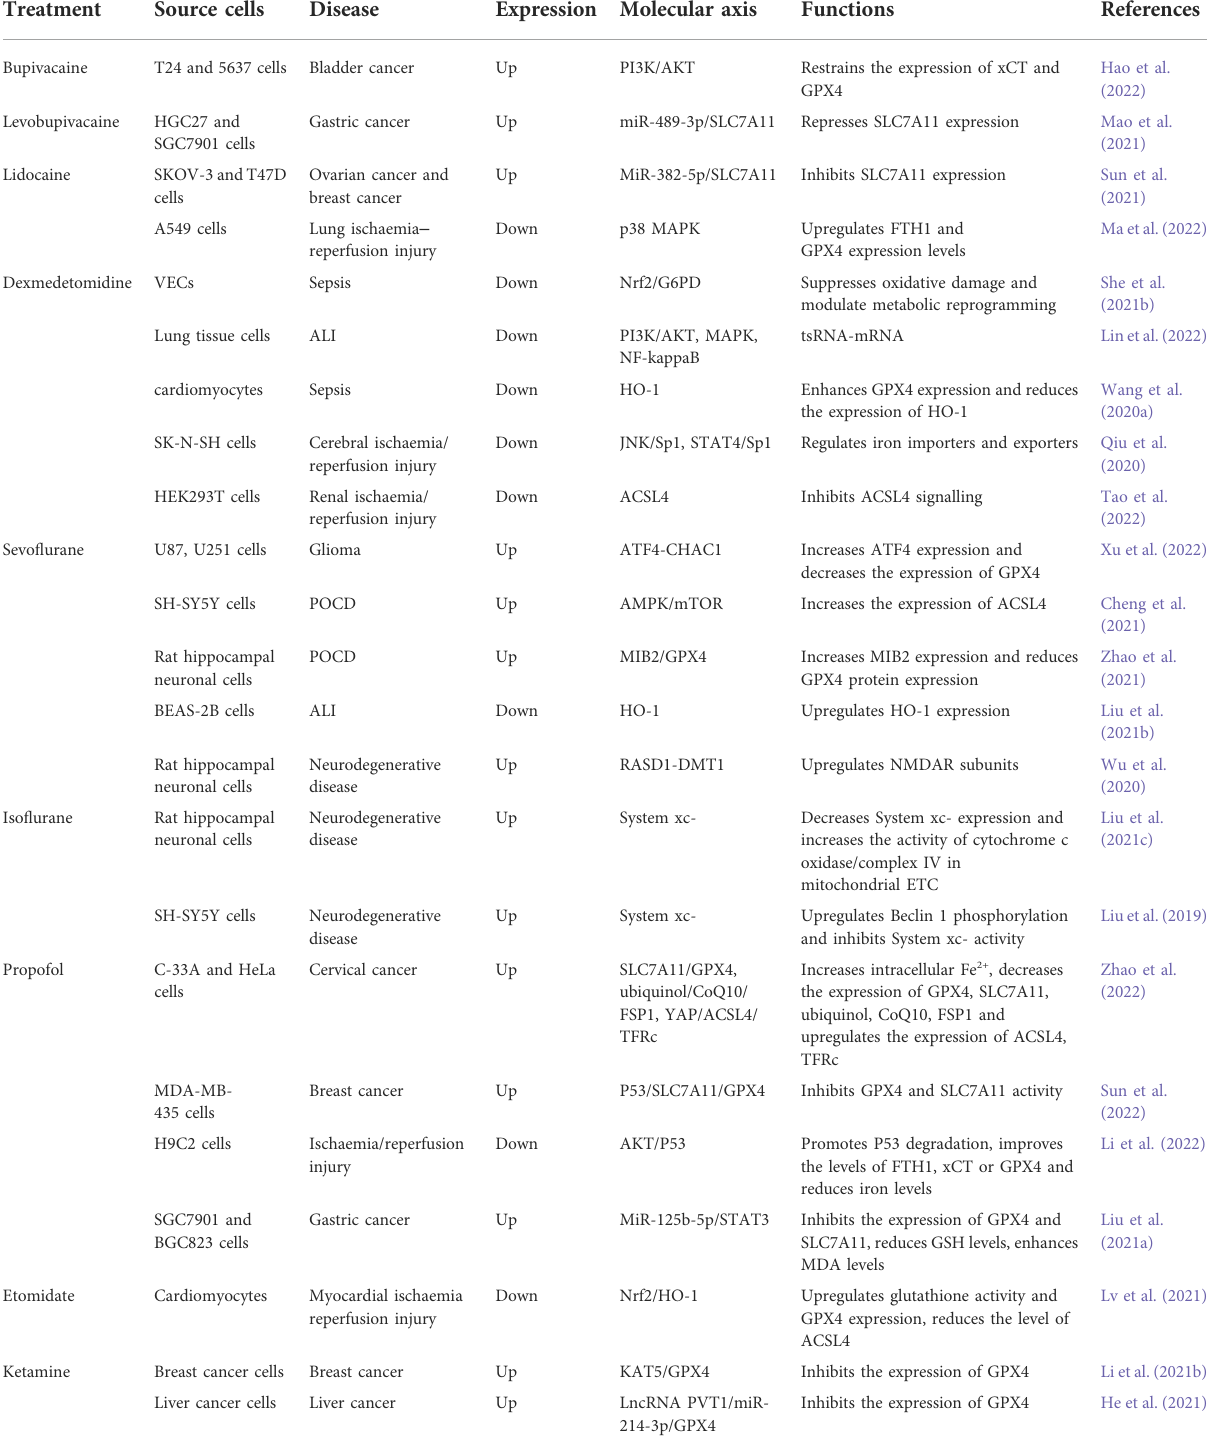
TABLE 3 Effects of narcotics on